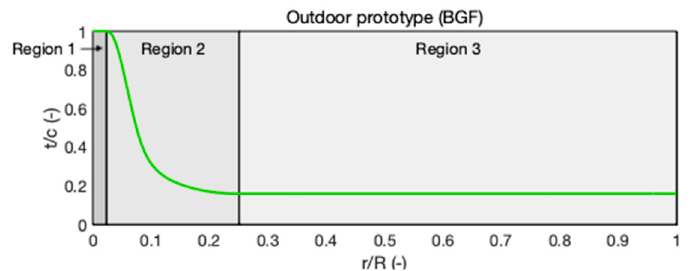
Figure 11. The radial distribution of the nondimensional thickness for the Blue Growth Farm model.